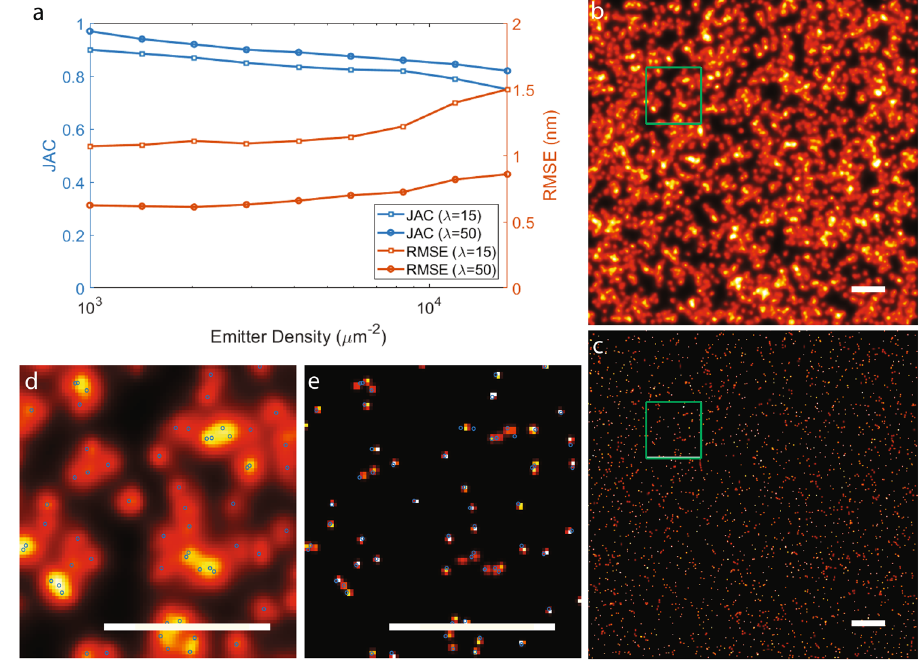
Fig. 4 | Jaccard index (JAC) and root mean square error (RMSE). JAC and RMSE were calculated for nine logarithmically spaced concentrations starting from 1000 emitters per μ m 2 to 17000 emitters per μ m 2 corresponding to average emitter separations ranging from 15.8 to 3.8nm. a JAC and RMSE was calculated by aver- aging over outcomes of fi ve simulated data sets for each concentration. b An example of simulated SR-data at a concentration of 10,000 emitters per μ m 2 (average emitter separation of 5nm) with λ =50 simulated over an area of